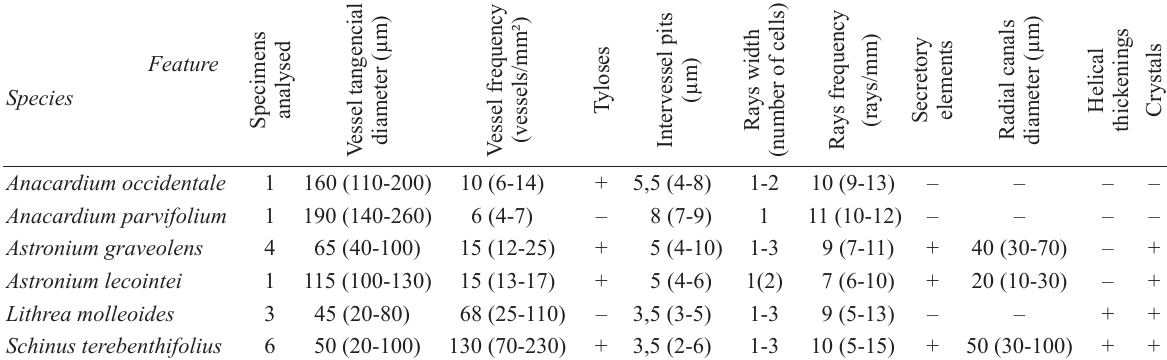
Number of specimens analyzes and synthesis of the charcoal anatomical features for the studied Anacardiaceae